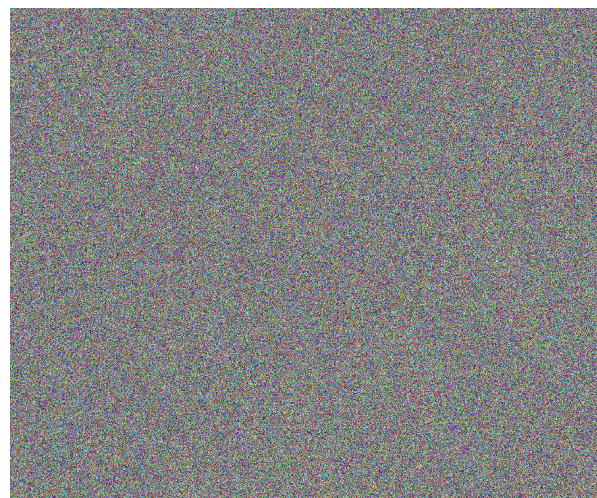
Figure 9. Encrypted Image